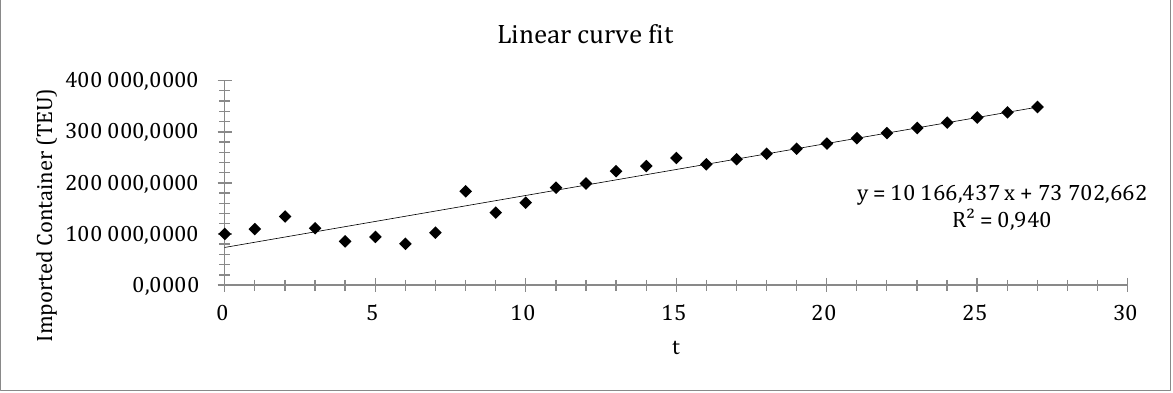
Source: Field Work, 2018.